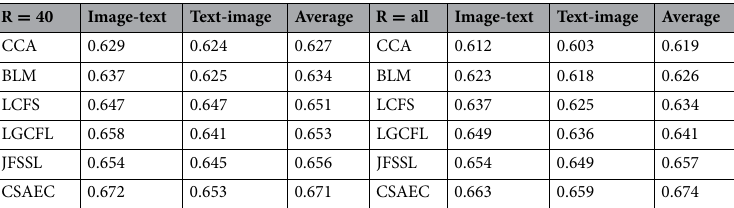
Table 2. MAP results of different methods (TVGraz).